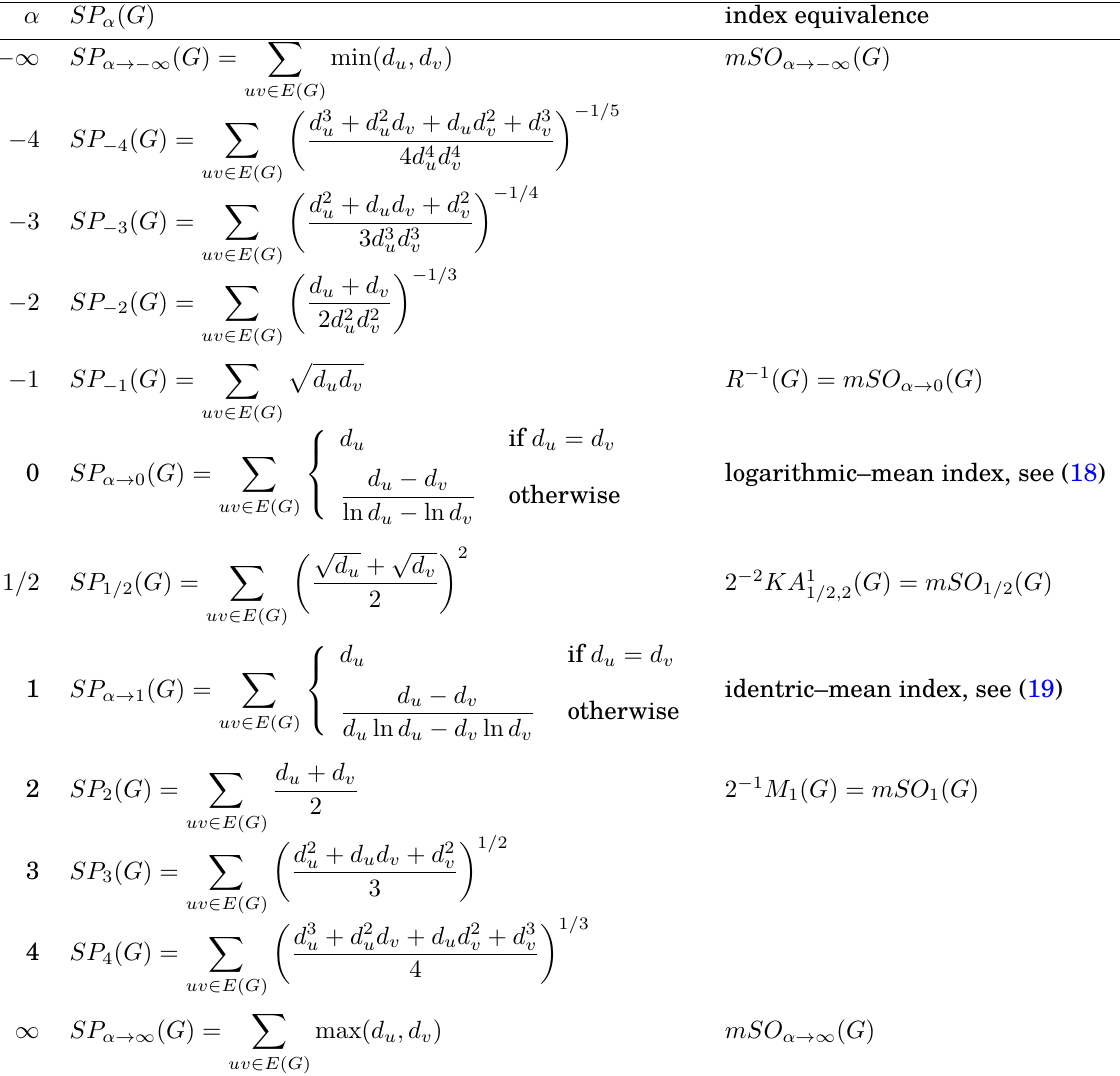
for selected values of α α ( G )